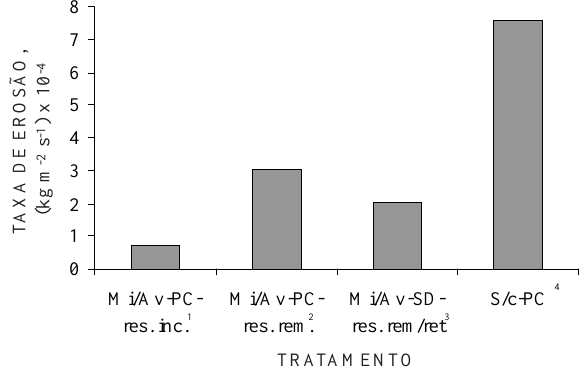
Figura 4. Valores médios da taxa de perda de solo sob enxurrada constante ( 1 Milho/aveia preta, preparo convencional, resíduo cultural incorporado; 2 milho/aveia preta, preparo convencional, resíduo cultural removido; 3 milho/aveia preta, semeadura direta, resíduo cultural removido e retornado; 4 sem cultivo, preparo convencional).